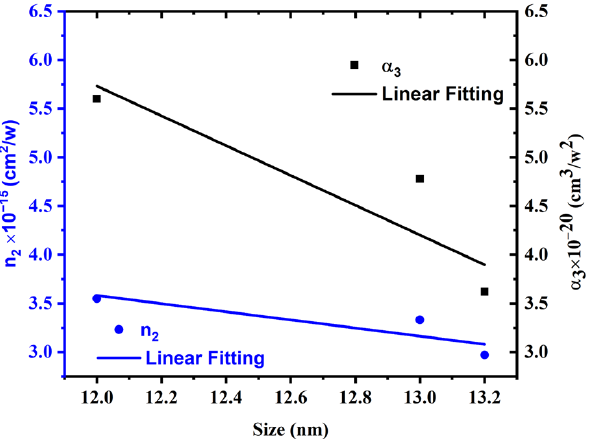
Figure 13. Dependence of n 2 and α 3 on average particle size at constant excitation power and wavelength of 1 W and 800 nm, respectively.